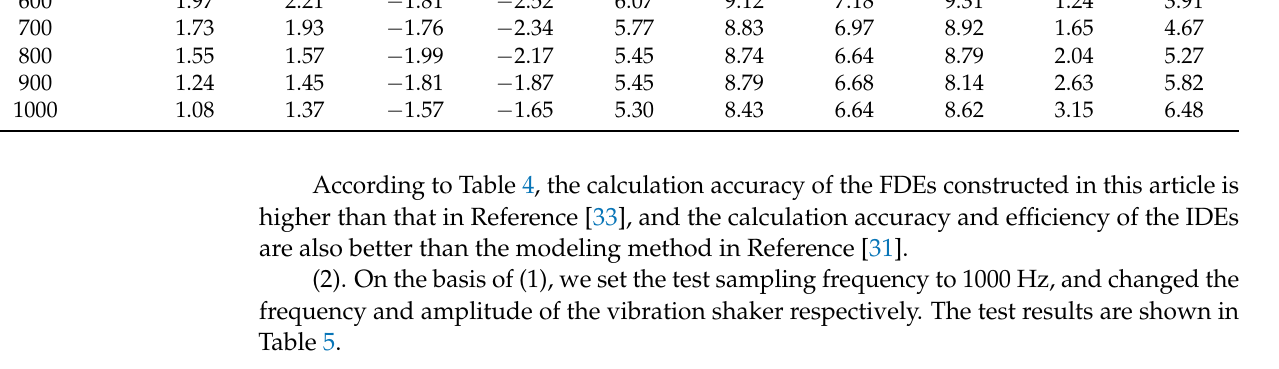
Table 5. Test results of the physical prototype of the